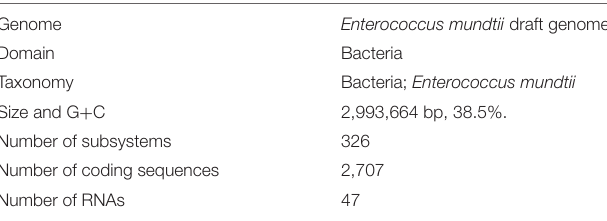
TABLE 5 | Metabolic subsystems features and counts (the table is generated using RAST